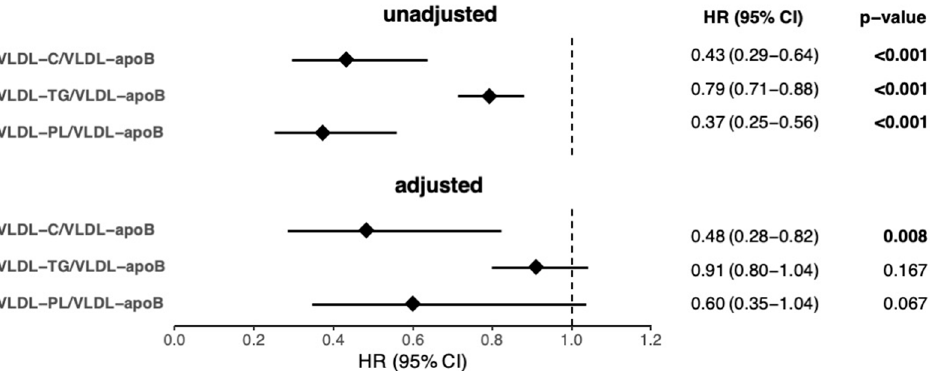
Figure 2. Cox regression analyses of the ratios estimating VLDL lipid content as predictors of 1 year mortality in AHF patients. In the adjusted model age, sex, BMI, MAP, eGFR, BUN, CRP, NT-proBNP, hemoglobin, ALT, albumin, and total cholesterol were used as covariates. For VLDL-C/VLDL-apoB and VLDL-PL/VLDL-apoB, the total number of patients and events in the univariable analyses was 314 and 117, respectively, and, in the adjusted analyses, these numbers were 302 and 111, respectively. For VLDL-TG/VLDL-apoB, the total number of patients and events in the univariable analyses was 313 and 117, respectively, and, in the adjusted analyses, these numbers were 301 and 111, respectively. Significant associations ( p < 0.05) are depicted in bold. AHF, acute heart failure; apoB, apolipoprotein B; BMI, body mass index; BUN, blood urea nitrogen; C, cholesterol; CI, confidence interval; CRP, C-reactive protein; eGFR, estimated glomerular filtration rate; HR, hazard ratio; MAP, mean arterial pressure; NT-proBNP, N-terminal pro brain natriuretic peptide; PL, phospholipids; TG, triglycerides; VLDL, very-low-density